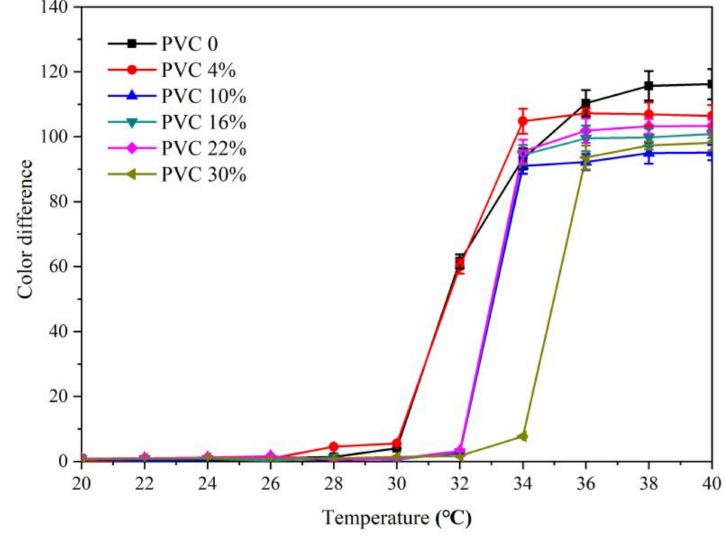
Figure 1. Influence of pigment volume concentration (PVC) of glass fiber powder on color di ff erence of thermochromic waterborne coatings from 18 to 40 ◦